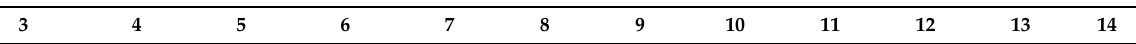
Table A2. Relationships between study